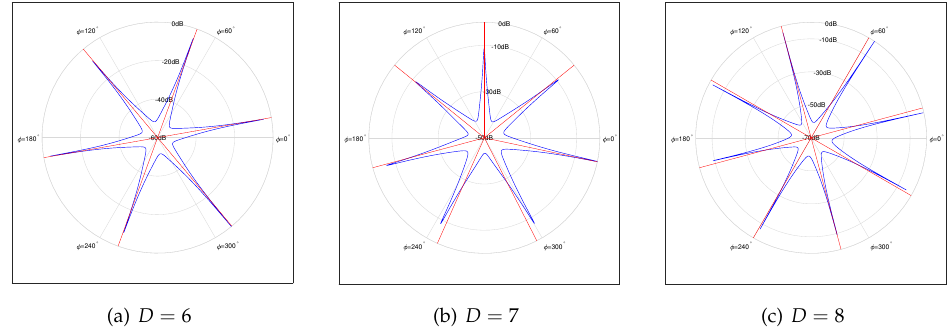
Figure 8. RMSE of 6, 7 and 8 Sources, ( N = 9, N p = 6).